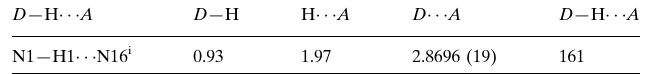
Hydrogen-bond geometry (A˚ , (cid:1)